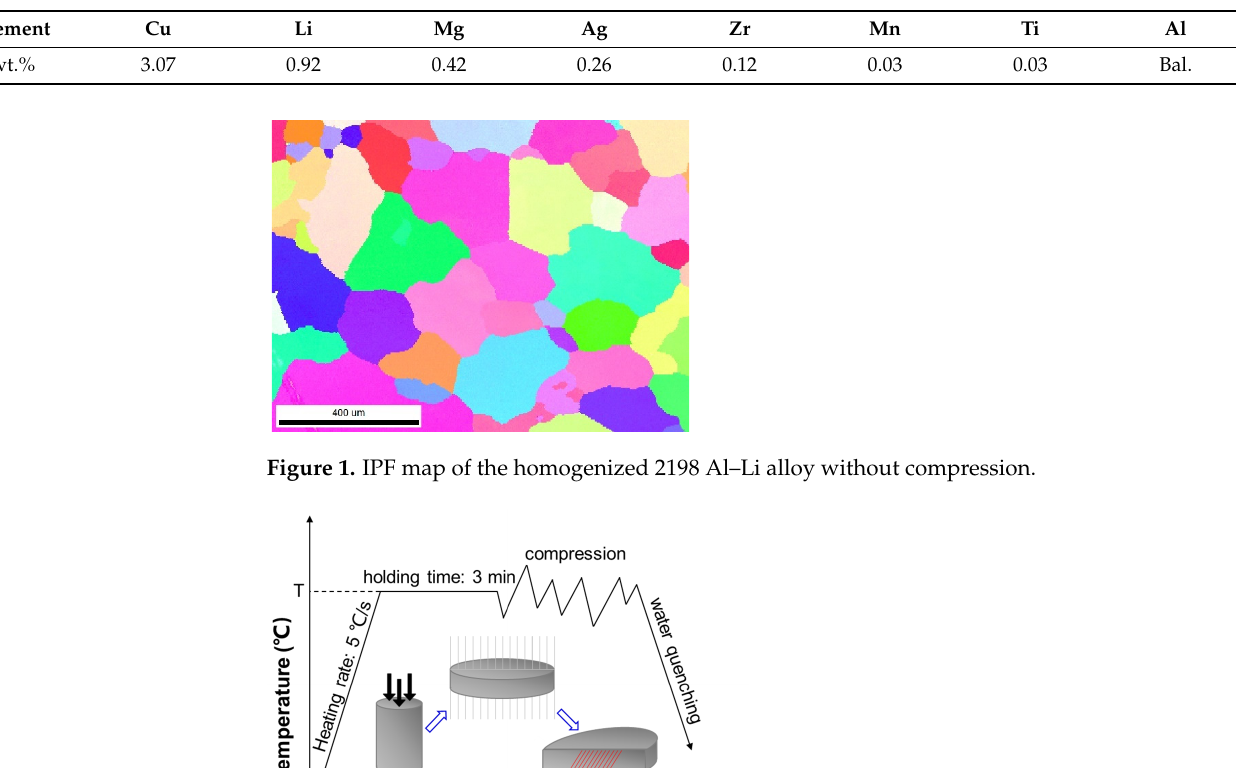
Table 1. Chemical composition of 2198 Al–Li alloy (wt.%).